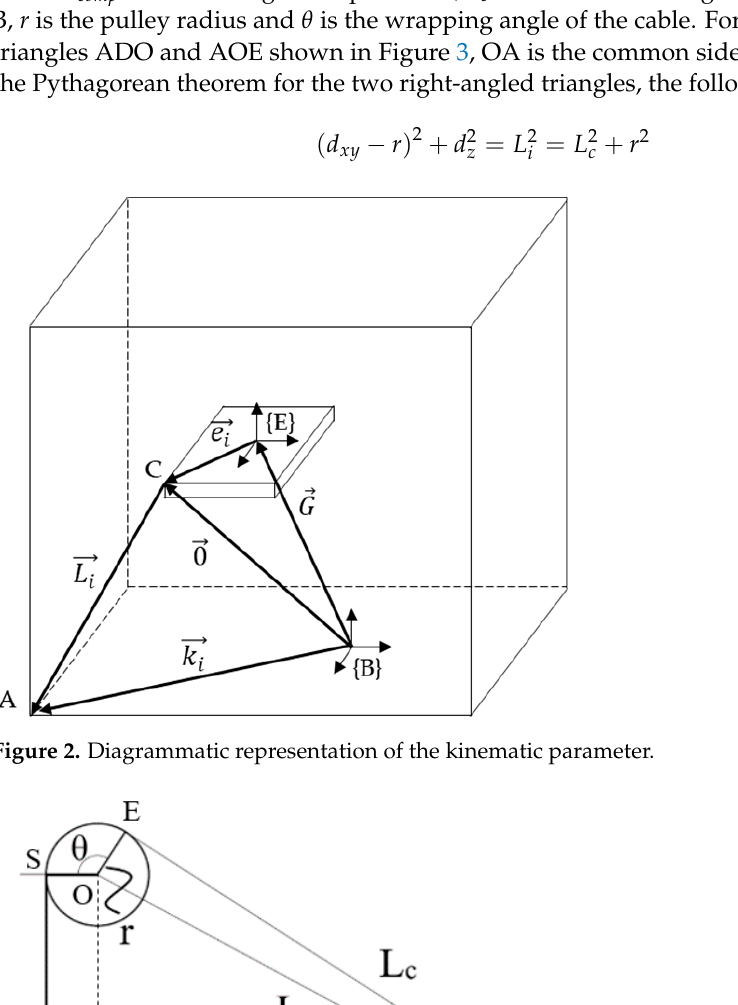
( b ) Figure 1. Schematic diagram of the CDPR system: ( a ) diagram of 6–DOF CDPR; ( b ) asymmetric pulley locations. 2.1. Kinematics of the Redundant-Actuated CDPR System Briefly reviewing the kinematic model, the geometry of the CDPR robot is described by its proximal anchor points on the robot frame and the distal anchor points on the end- effector, which were defined by the vector. Figure 2 shows that B was the origin of the